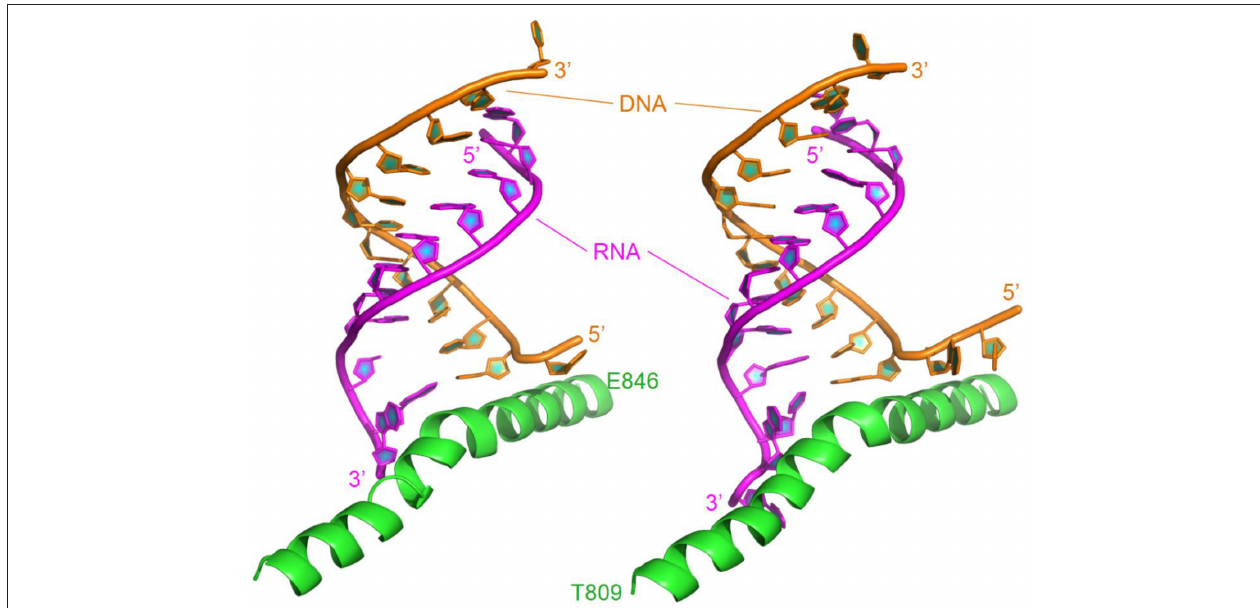
FIGURE 1 | Ribbon representation of the original structures of bound DNA/RNA hybrids with DNA damage (left) and DNA/RNA mismatches (right). Polymerase is in green, DNA in orange, and RNA in magenta.